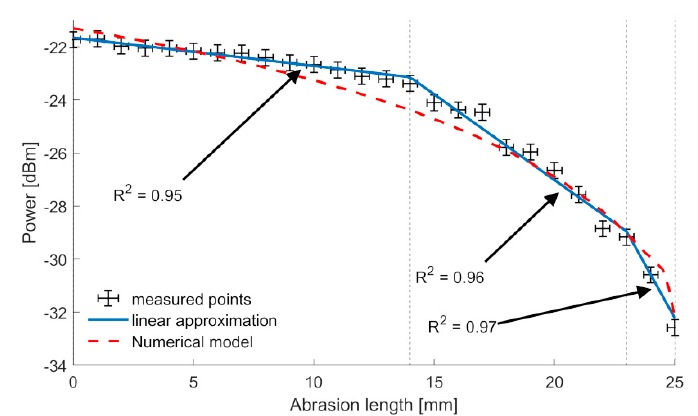
Figure 10. Abrasion–reflectance relation graph.